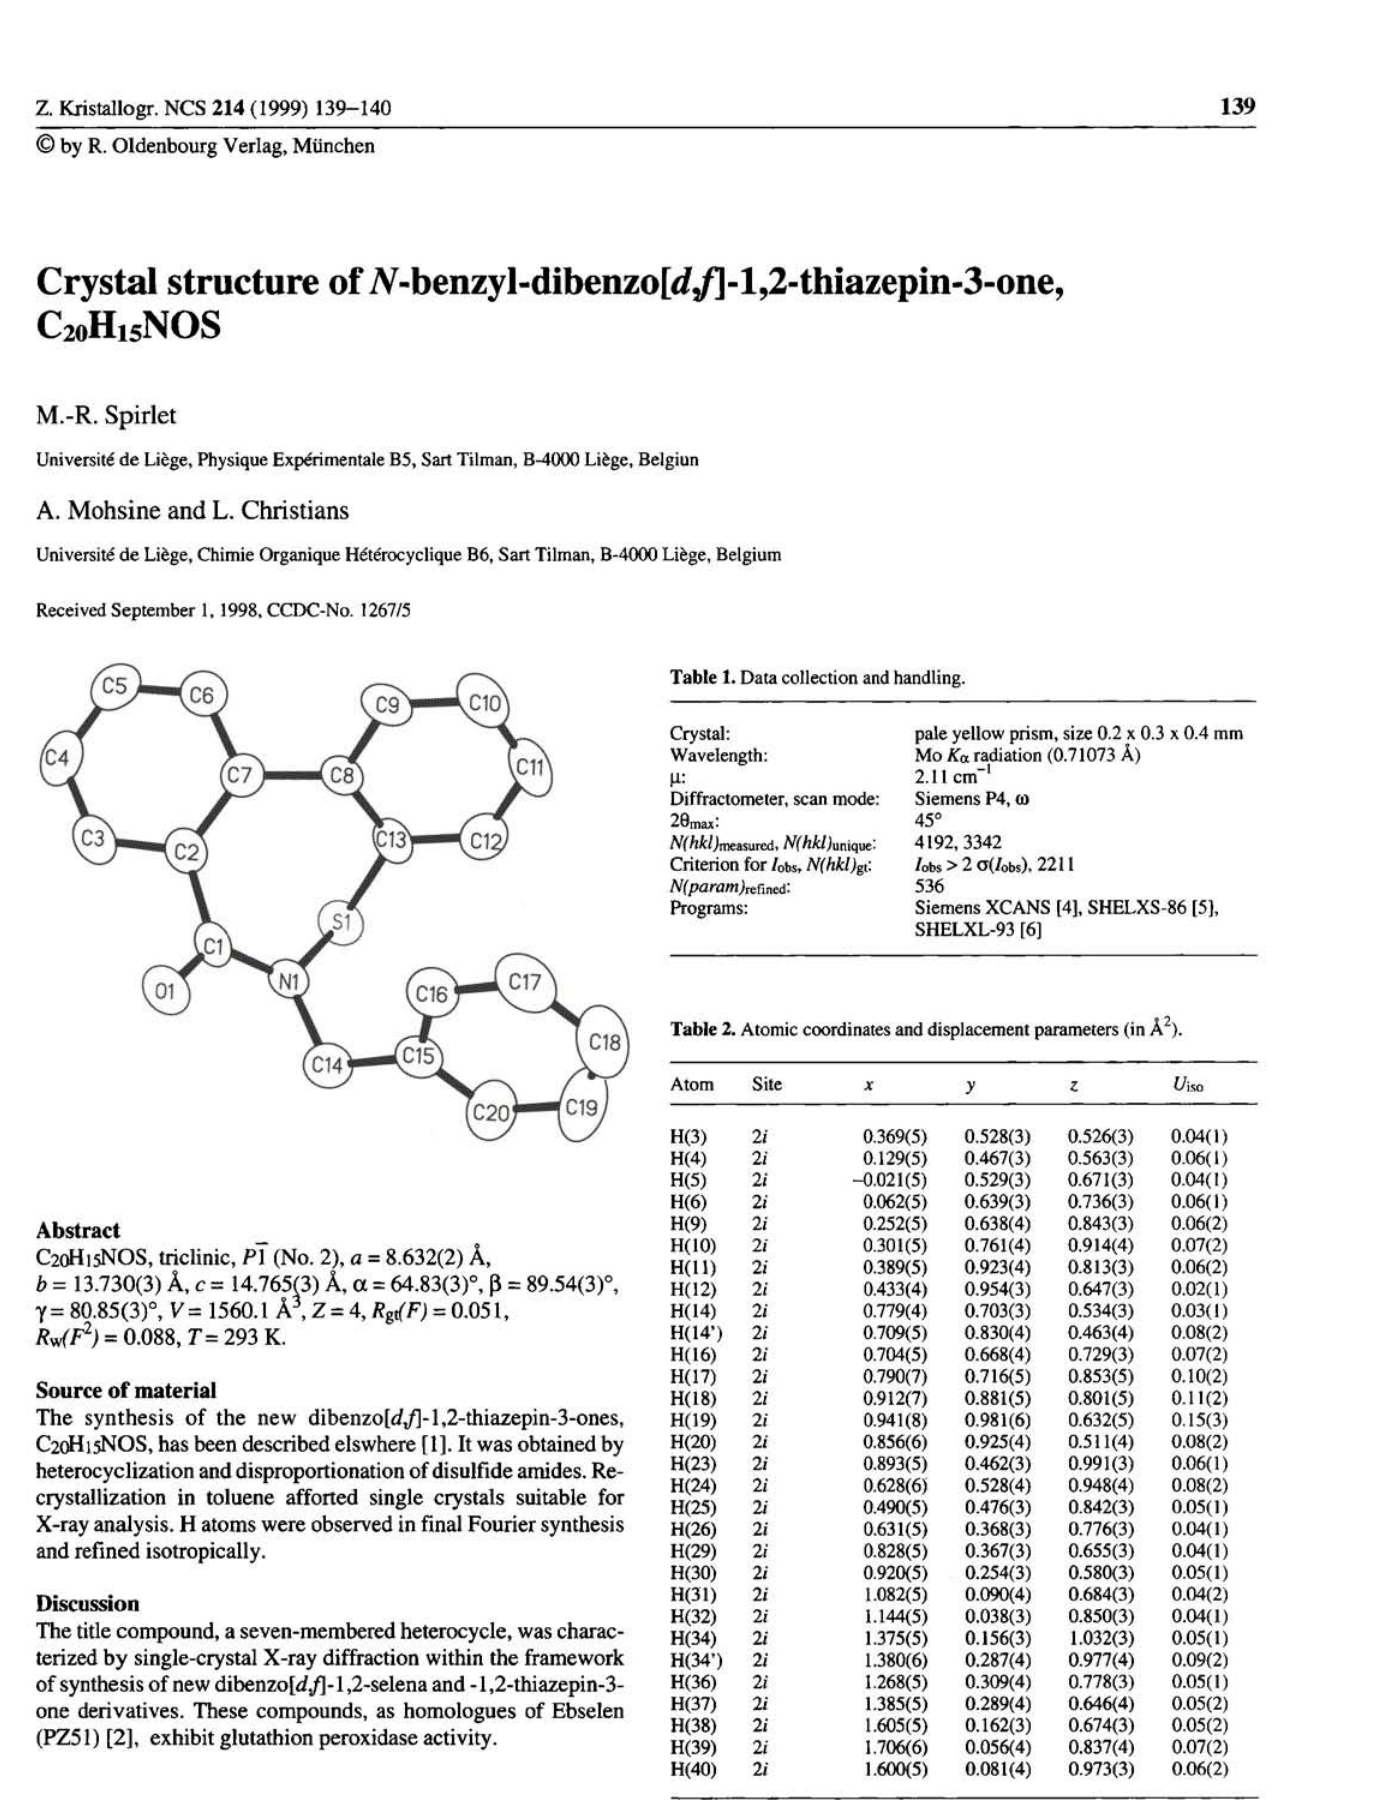
Table 2. Atomic coordinates and displacement parameters (in Â 2